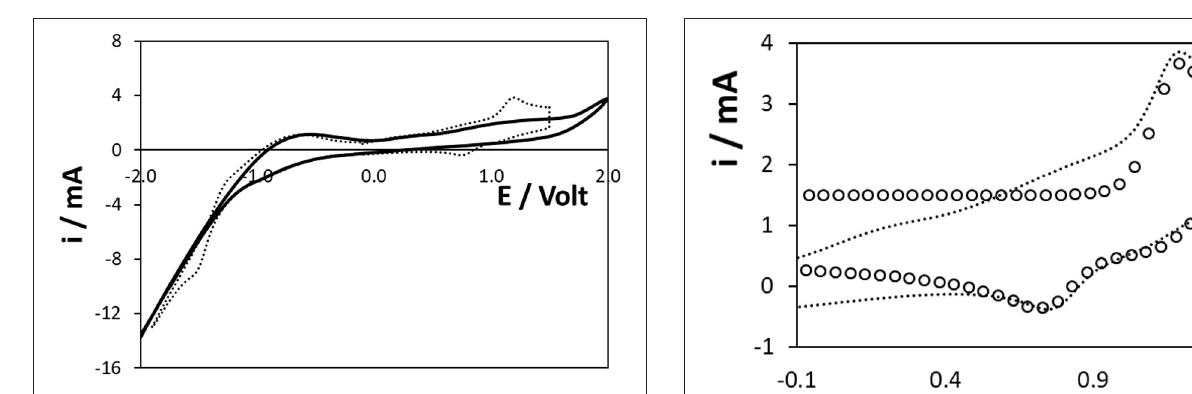
FIGURE 2 | Voltammograms of the 3D Ti electrode in pure electrolyte (solid line) and a 10mM solution of [Ru(bpy) 3 ] 2 + (dashed line). The electrode had a native oxide layer and the quiet time at 0.000V was 5s. The supporting electrolyte is aqueous 0.1M H 2 SO 4 . The scan rate is 0.1V s − 1 . The solution contains oxygen.